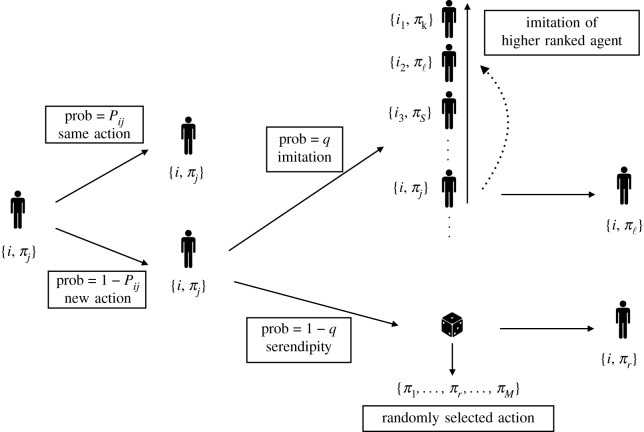
Sketch of the model. At the beginning of a time step, agent i is playing action j, which awards a pay-off πj. With probability equal to the individual pay-off Pij = αij πj (see equation (2.1)), the agent keeps playing the same action, and with probability 1 − Pij switches to a new action, which is determined either via imitation or via serendipity. With probability q, the agent adopts the action being played by a (randomly selected) better ranked agent, while with probability 1 − q the agent selects a new action at random.